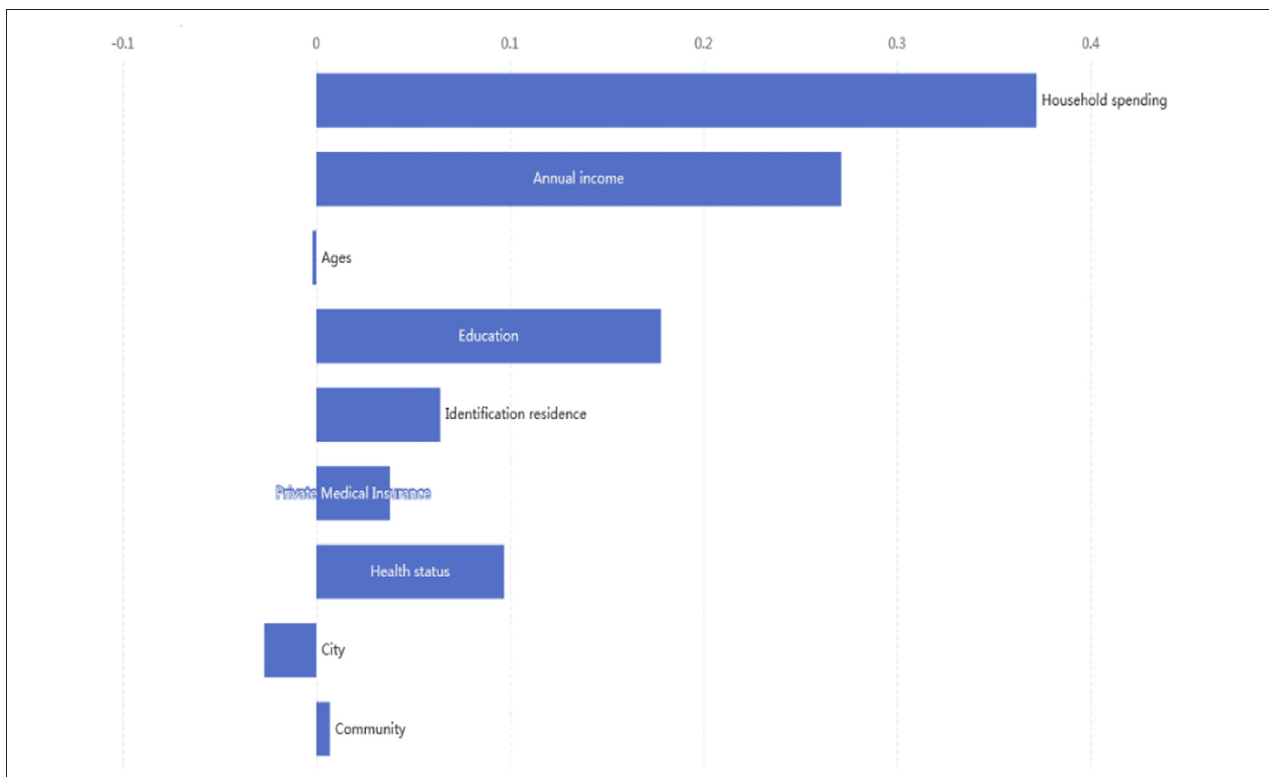
FIGURE 4 | Contributions of socioeconomic to inequality in health